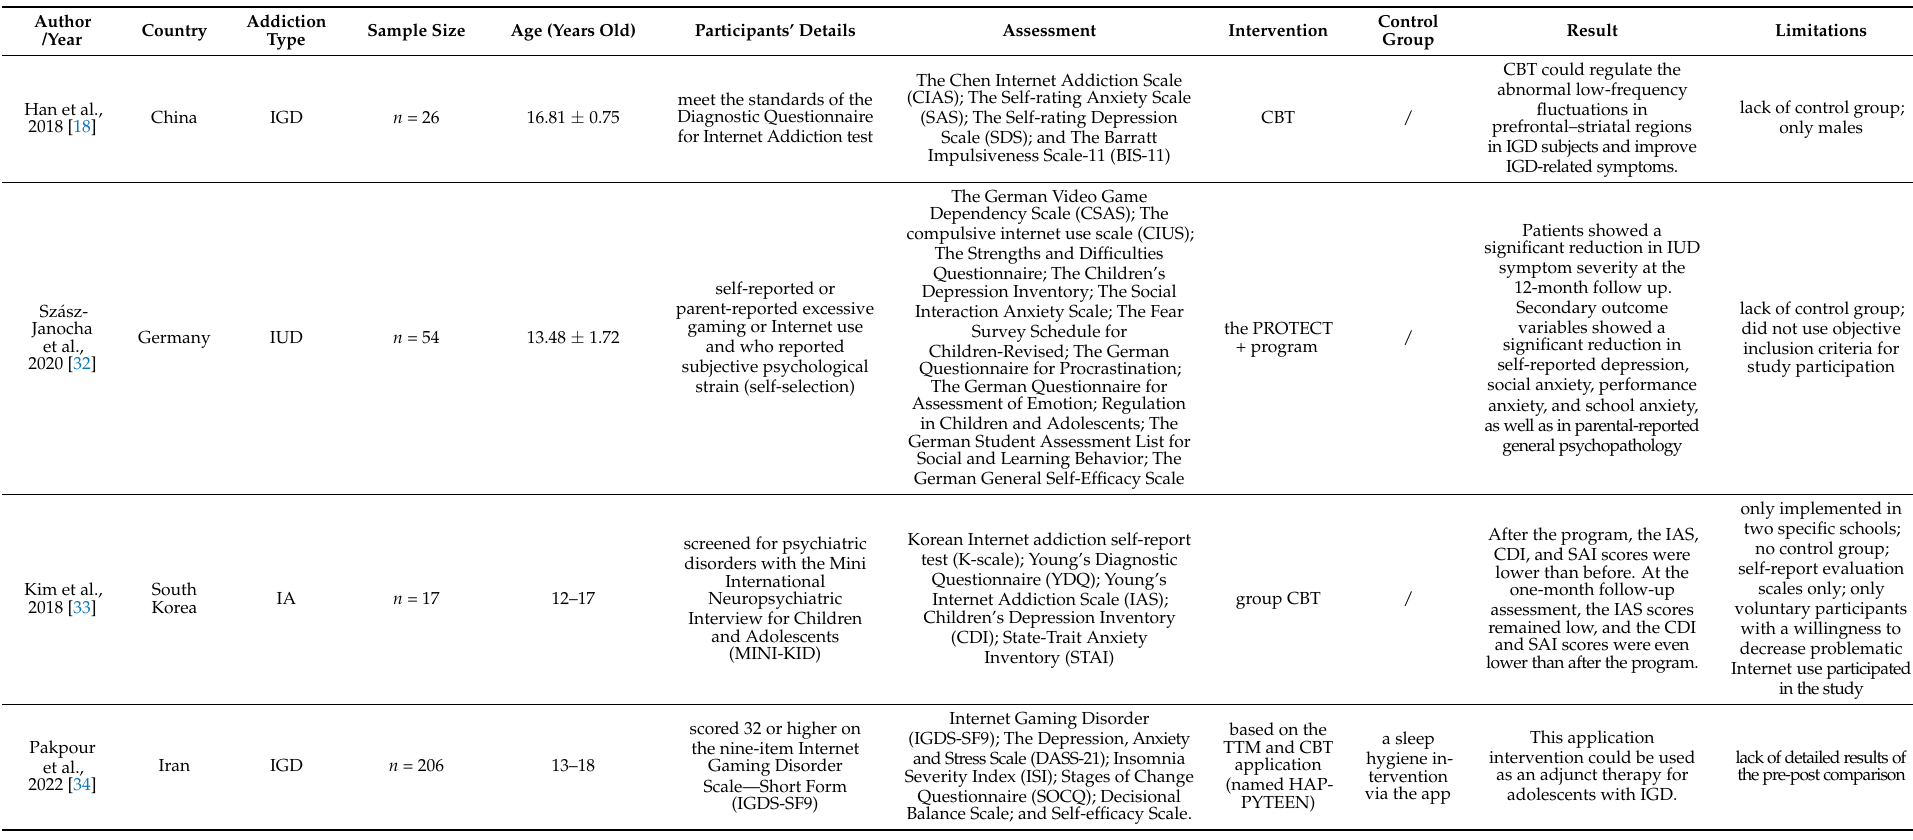
Table 1. Digital Addiction Intervention for Children and